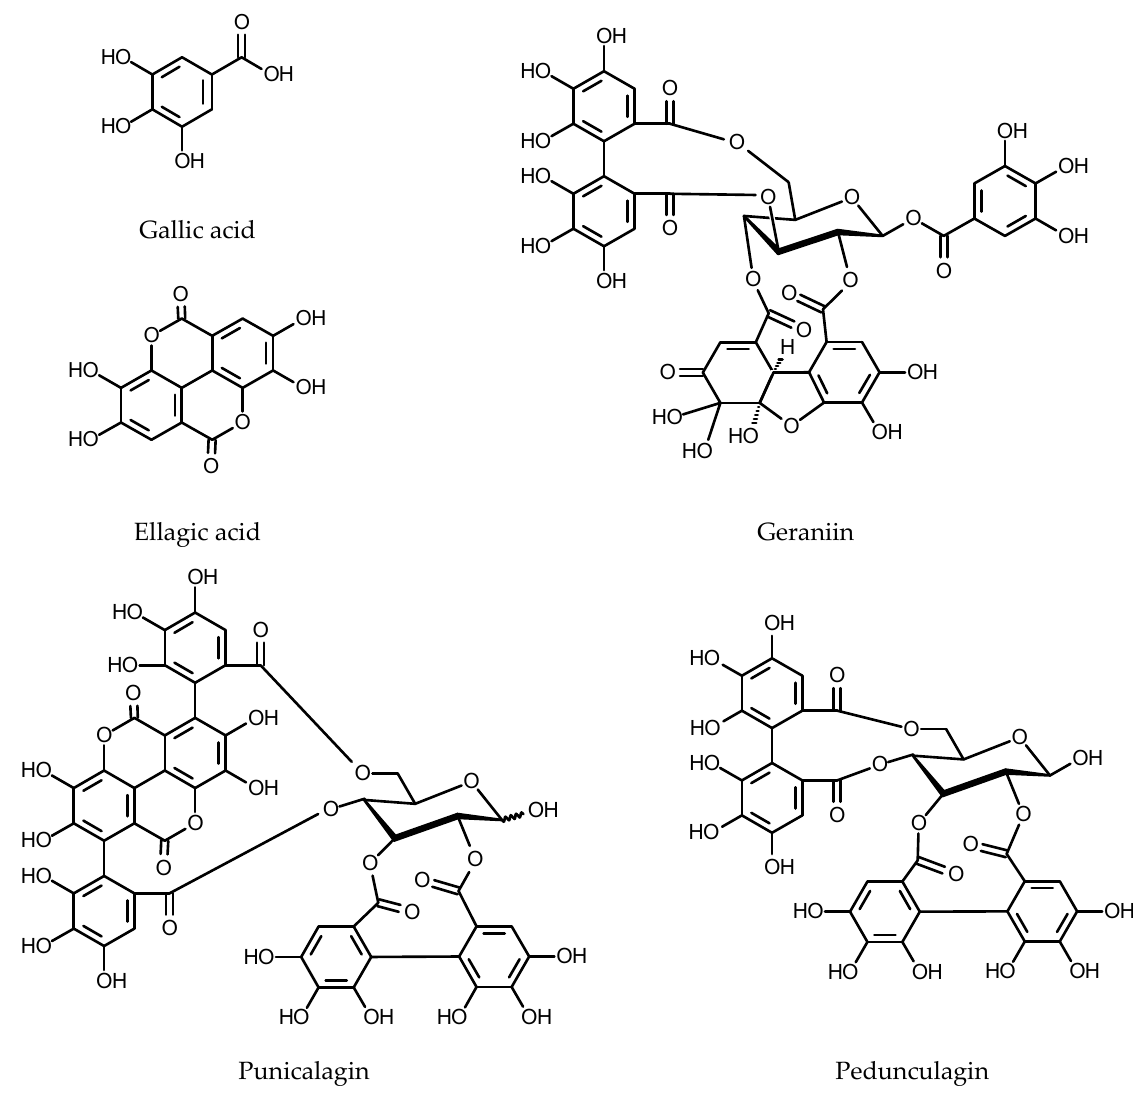
Figure 8. Chemical structures of gallic acid, ellagic acid and selected hydrolyzable tannins. Sanguisorba officinalis L. (Rosaceae) has been traditionally used as hemostatic and wound healing medicine. The HRs of the plant were obtained by inoculation with R. rhi-